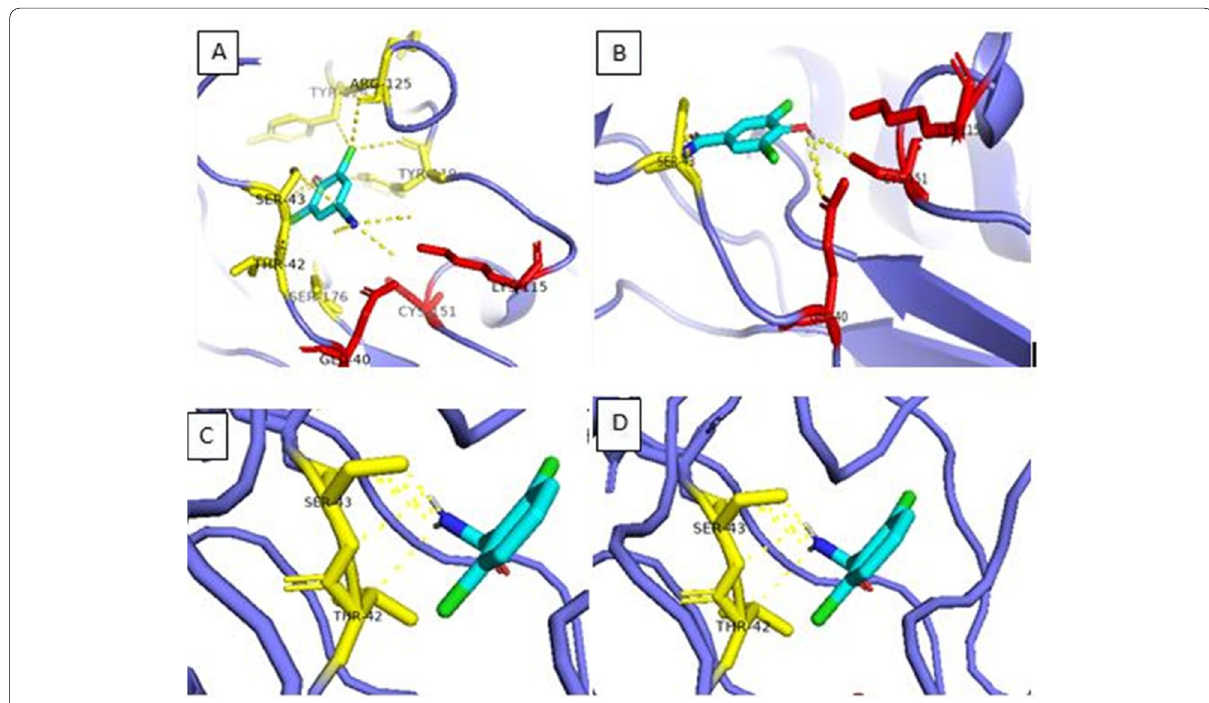
Fig. 7 Molecular docking analysis of nitrilase-3 protein with its ligands. A Bromoxynil. B Chloroxynil. C BAM. D